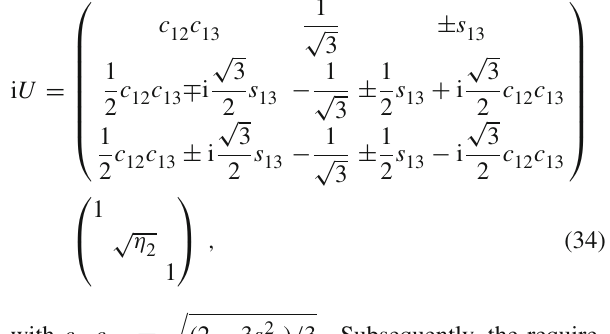
Fig. 2 In the TM2 μ - τ reflection symmetry scenario, the fitted values of a 2 , T and IO cases with η